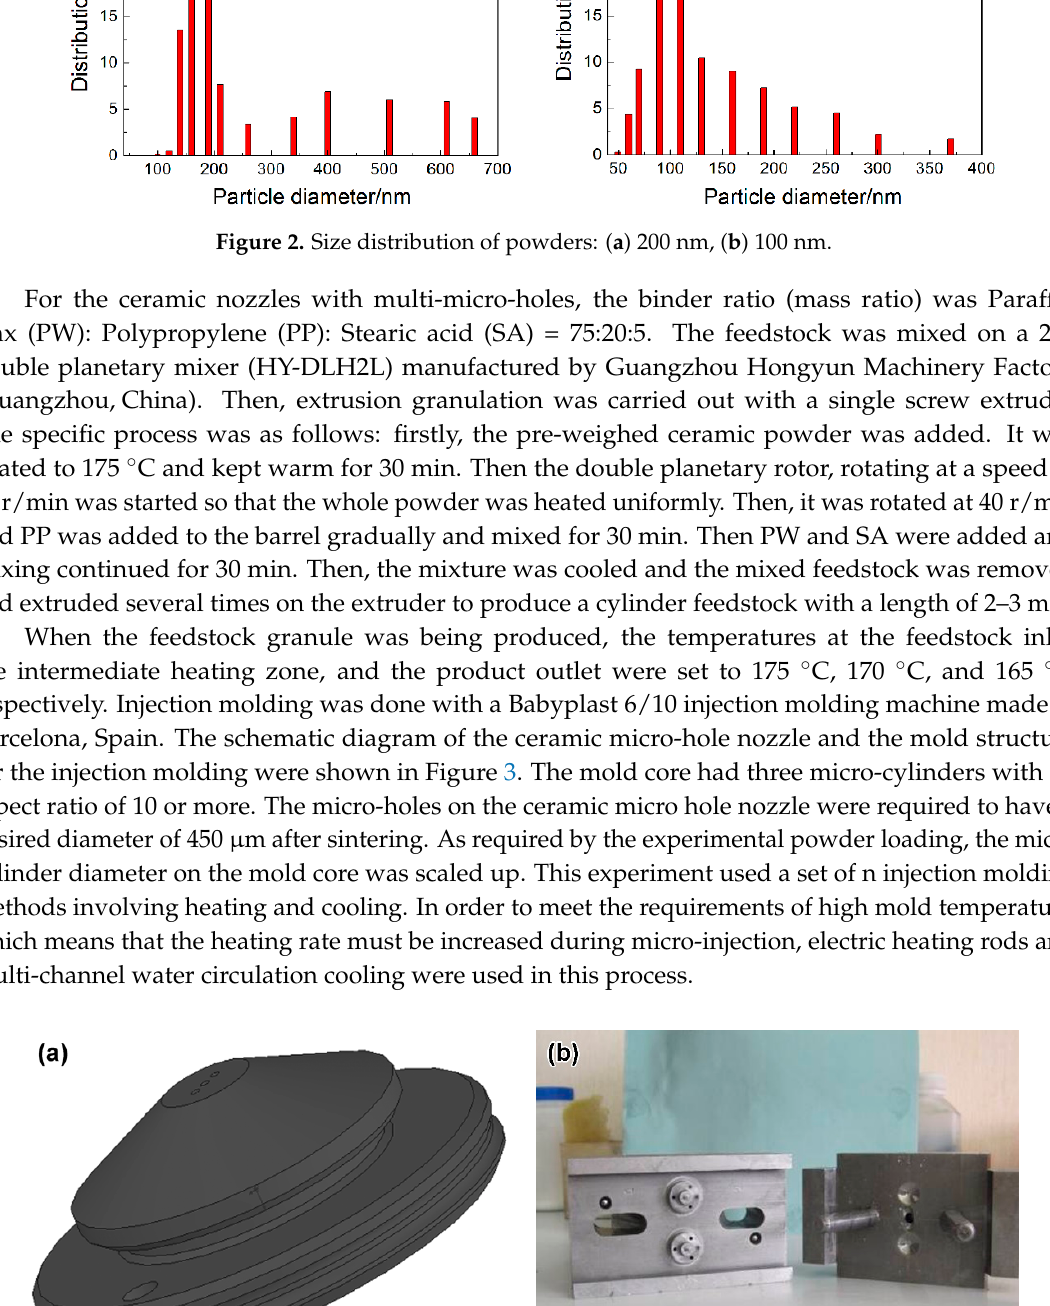
Table 1. Chemical composition of ZrO 2 powder (wt.%).